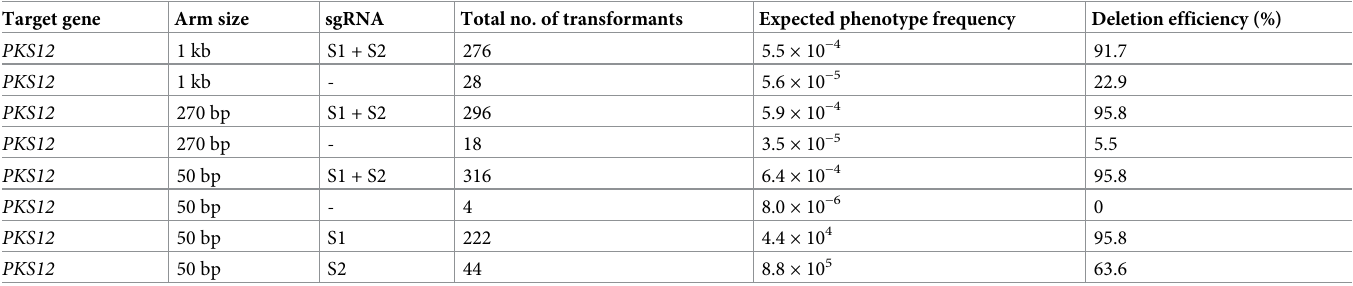
Table 3. Deletion efficiencies were lower when the homologous arm size of the construct was shorter. Because of variation in the transformation results, this table shows a representative experiment. Target